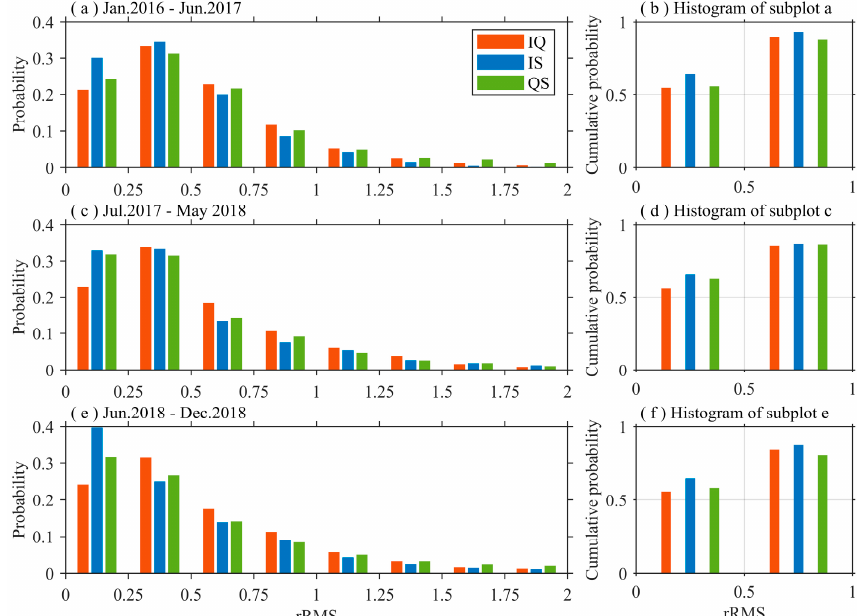
Figure 6. Probability distributions of Figure 4. Subplots ( a , c , e ) display the probabilities of rRMS values of IGG relative to QF (IQ), IGG relative to SSA (IS), and QF relative to SSA (QS), respectively, during three periods: January 2016 to June 2017, July 2017 to May 2018, June 2018 to December 2018. Subplots ( b , d , f ) display the cumulative probabilities of ( a , c , e ), respectively.